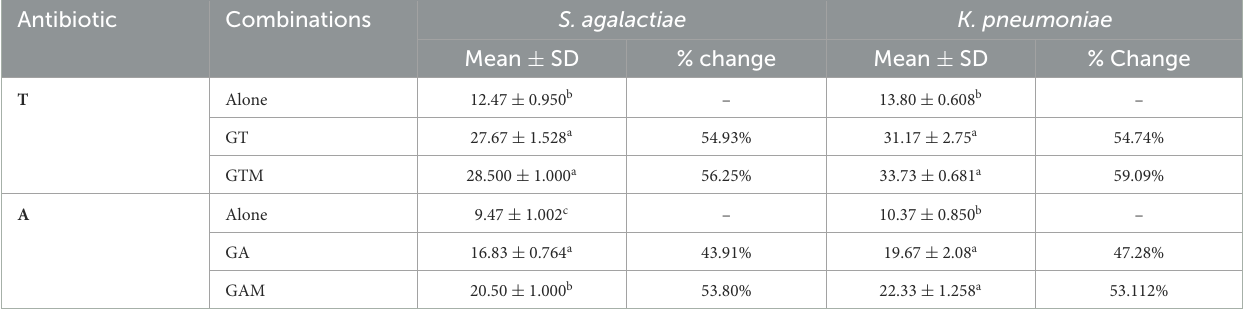
TABLE 3 Comparison of the antibacterial activity (zone of inhibition) of sodium alginate-stabilized antibiotic and nanoparticles against bacteria. Antibiotic